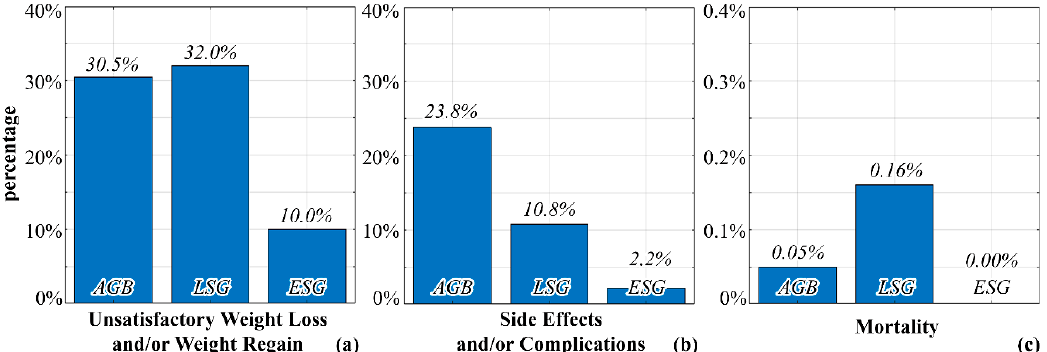
Figure 1. Identification of the weaknesses of traditional and current bariatric surgery (BS) techniques, with particular regard to unsatisfactory weight loss and/or weight regain ( a ), side effects and/or postsurgical complications ( b ), and mortality ( c ) [15–24].